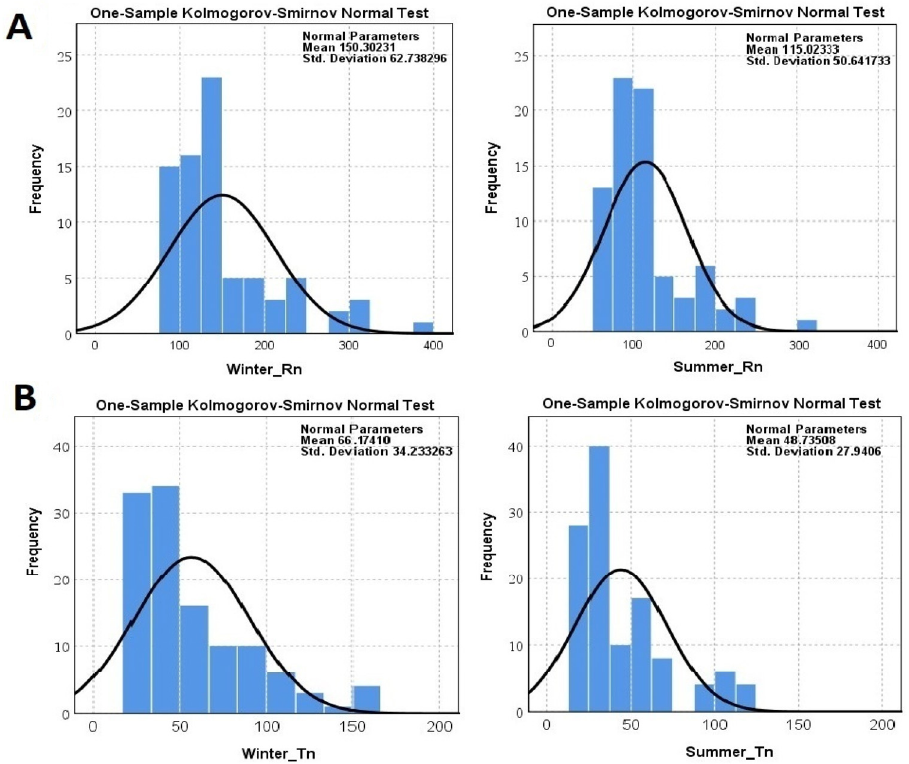
Figure 2. Normal Distribution of indoor ( A ) radon and ( B ) thoron concentrations (Bq m − 3 ) over the two seasons at the ground level of dwellings examined in